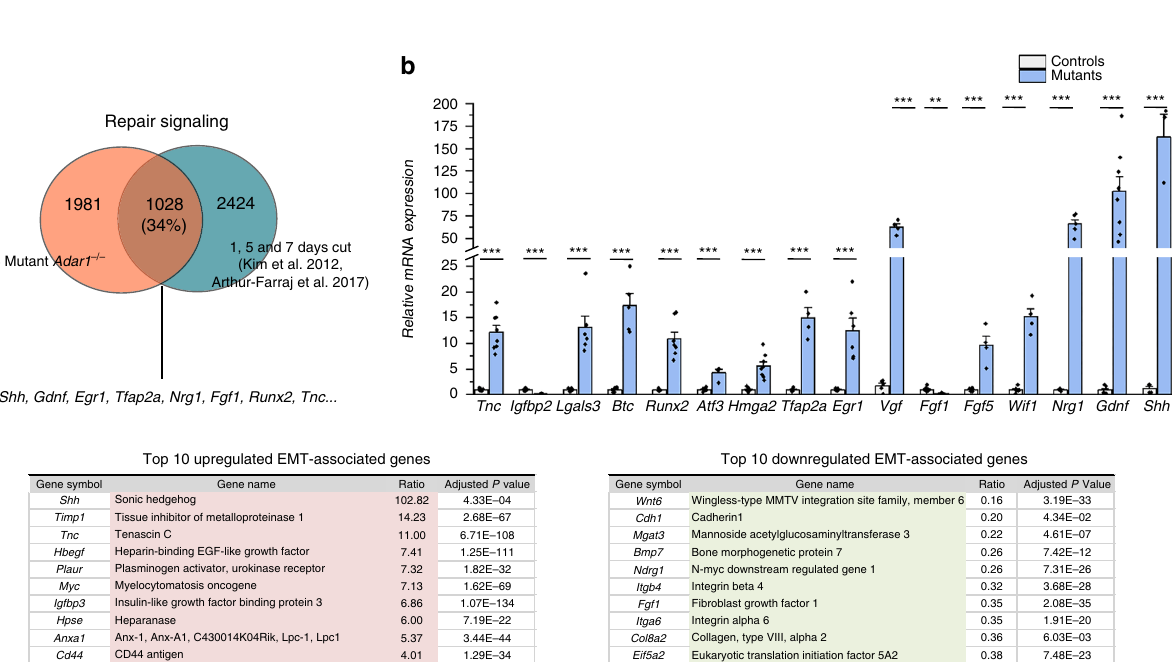
Fig. 5 Transcriptomic analysis of sciatic nerves in mutants relative to controls. a Volcano plot of differentially expressed genes in sciatic nerves of HtPA- Cre; Adar1 fl / fl mutants compared to controls (upregulated in mutants: red; downregulated in mutants: green; unchanged in black). Results were considered statistically signi fi cant for p values ≤ 0.05 and fold-changes ≥ 2.0 ( n = 3 for each condition) using Deseq2 R package for differential analyses. In all, 1664 were upregulated in the mutant versus control animals and 1345 were downregulated, suggesting ADAR1 is involved in mechanism governing gene repression and activation. b Validation of a subset of differentially regulated genes on RNA extracted from isolated sciatic nerves from controls and mutants by RT-qPCR. Relative expression levels in controls (gray) and mutants (blue) are presented as mean ± SEM. Statistical differences between the groups ( n = 4 controls and n = 4 mutants) were determined using t test (asterisks represent p values: * p < 0.05, ** p < 0.01, *** p < 0.001). Source data are provided as a source data fi le. c Heatmap representation of RNA-seq analysis depicting the top 50-up and 50-downregulated genes in mutants relative to controls. Colors re fl ect the z -score. d Representation of enriched functions by GO term and enriched signaling pathways (using GO analysis and Ingenuity). e Functions/signaling pathways e nriched in mutants versus controls are indicated in red, those enriched in controls versus mutants are indicated in light green. f The interferome database V2.01I [http://interferome.its.monash.edu.au/interferome/] was used to determine the number of interferon regulated genes (IRGs) speci fi c to different types of Interferon IFN (I, II and III) within the 3009 differentially regulated genes upon Adar1 deletion. Overlap of 75% (2253/3009) was evidenced. Fisher ’ s exact test con fi rmed enrichment ( p < 2.2E-16). g Heatmap representation of differentially expressed transcriptional regulators (found in association with GO terms: DNA-templated transcription, positive or negative regulation of transcription from RNA polymerase II promoter, positive or negative regulation of transcription, DNA-templated transcription factor activity, sequence-speci fi c DNA binding, and positive regulation of gene expression). Out of the 281 factors identi fi ed, 69 were deregulated more than fi vefold in mutants relative to controls. Name of each gene is indicated on the left, along with its belonging to the Interferome dataset. Colors re fl ect the z -score.